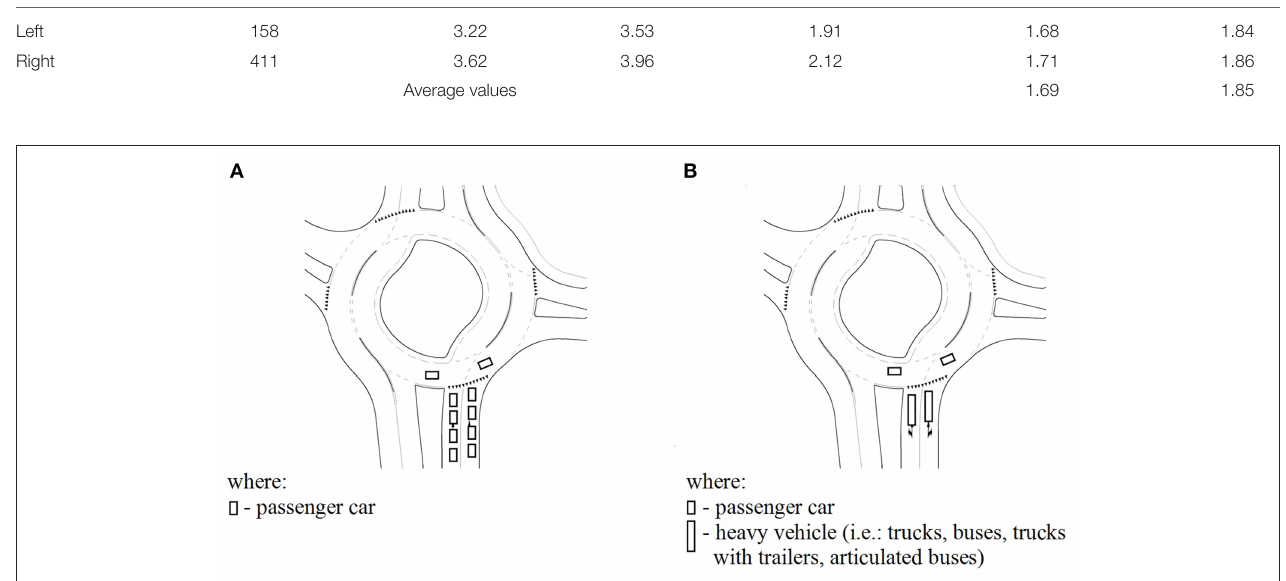
FIGURE 4 | The situations taken into account in measurements of critical gaps for vehicle drivers at turbo roundabouts. (A) Only passenger cars. (B) Passenger cars and heavy vehicles (i.e., trucks, buses, truck with trailers, articulated buses).